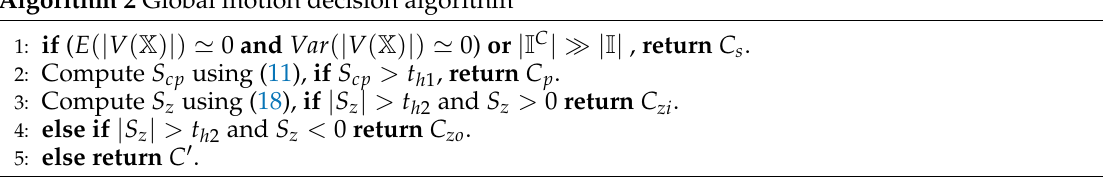
Algorithm 2 Global motion decision